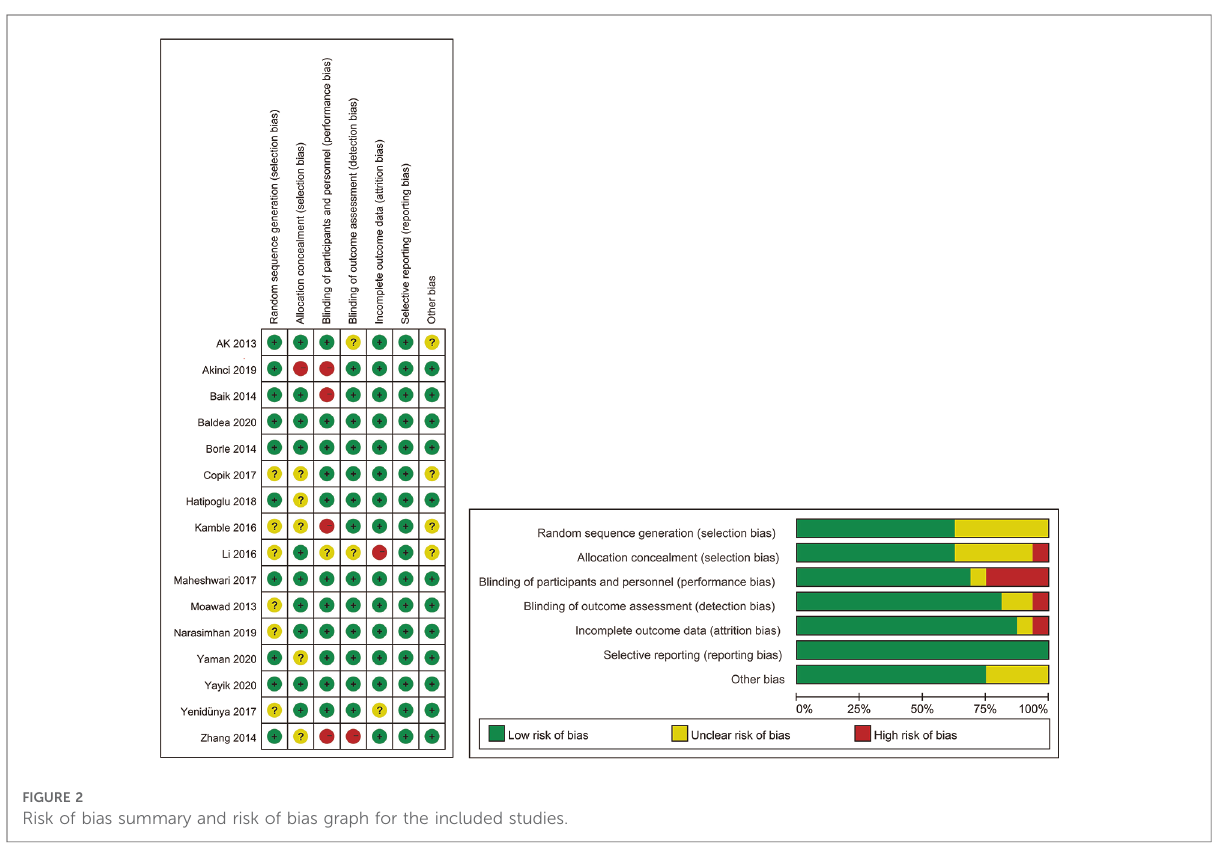
FIGURE 2 Risk of bias summary and risk of bias graph for the included studies.